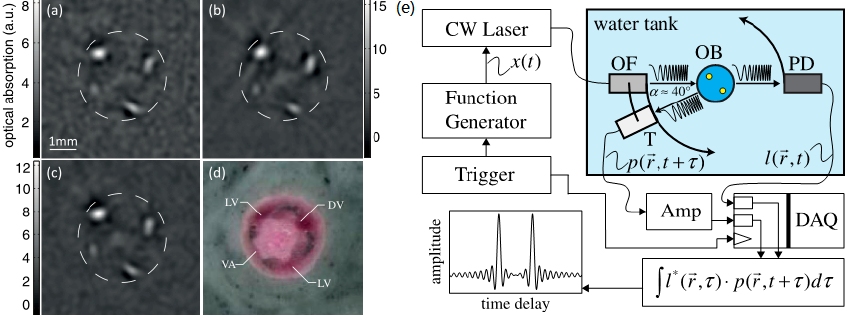
Figure 14. ( a ) FD-optoacoustic tomography (FD-OAT) in vivo mouse tail image without ICG, ( b ) FD-OAT tail image during ICG injection, ( c ) tail image ~ 10 min after initial ICG injection, ( d ) cryoslice of the mouse (LV, lateral caudal veins; DV, dorsal caudal vein; VA, ventral caudal artery; dashed circle represents approximate tail surface), ( e ) schematic diagram of the frequency domain optoacoustic tomography system. An optical fiber (OF) guides the laser chirps onto the object (OB). Signals from the photodetector (PD) and the transducer (T) are acquired simultaneously by the data acquisition (DAQ) and afterwards are cross-correlated. Reproduced with permission from Ref. [90].